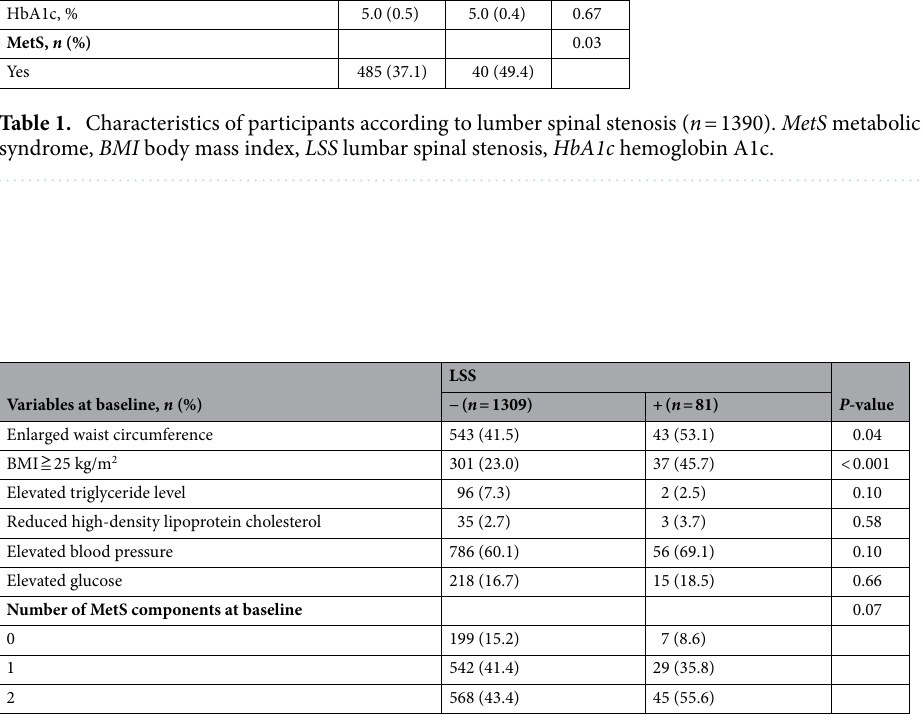
Table 2. Relationship between lumber spinal stenosis and the metabolic syndrome components and body mass index at baseline ( n = 1390). Enlarged waist circumference: ≥ 80 cm in females or ≥ 90 cm in males; elevated triglyceride level: ≥ 150 mg/dL, or taking a drug prescribed for high triglycerides; low high-density lipoprotein cholesterol: < 50 mg/dL in females or < 40 mg/dL in males, or taking drugs prescribed for low high- density lipoprotein cholesterol; elevated blood pressure: systolic blood pressure ≥ 130 mmHg and/or diastolic blood pressure ≥ 85 mmHg, or being under antihypertensive drug treatment; elevated glucose: hemoglobin A1c ≥ 5.6% or taking a drug prescribed for elevated glucose. BMI body mass index, LSS lumbar spinal stenosis, MetS metabolic syndrome.